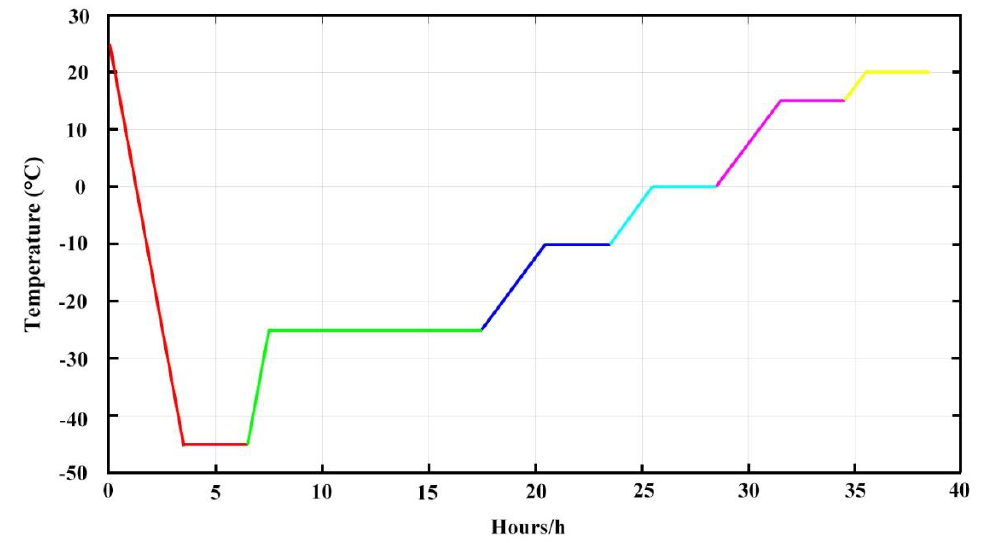
Figure 1. Freeze-drying processes.